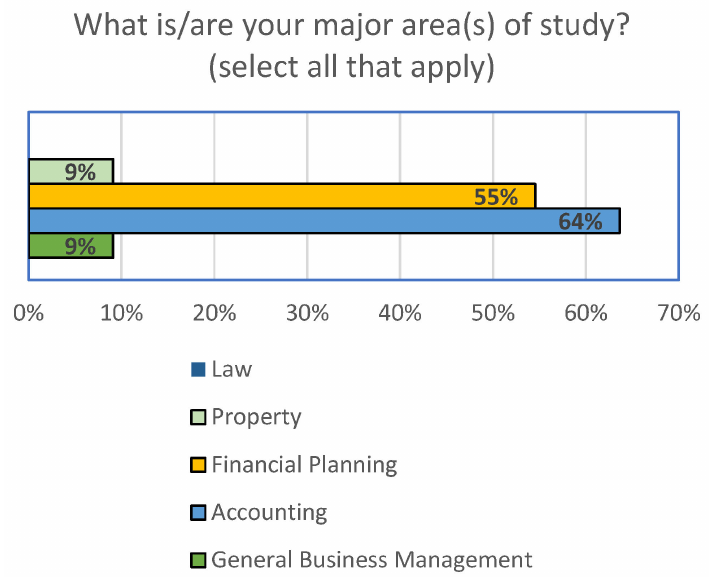
Figure 6. The study area of respondents. Professionally, respondents primarily worked for an organisation full time (Figure